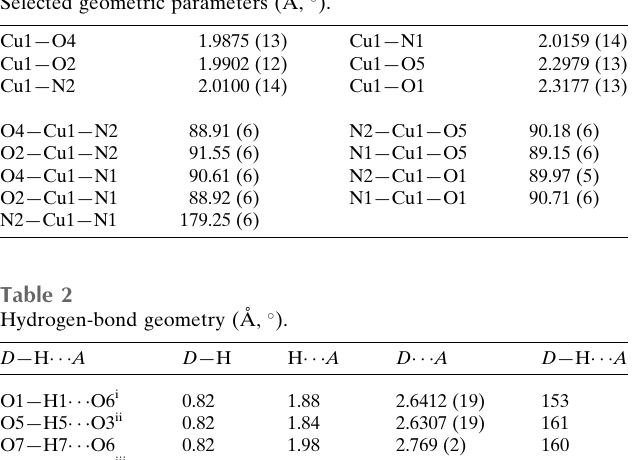
Table 1). The two O—Cu—O bite angles are 76.16 (5) and